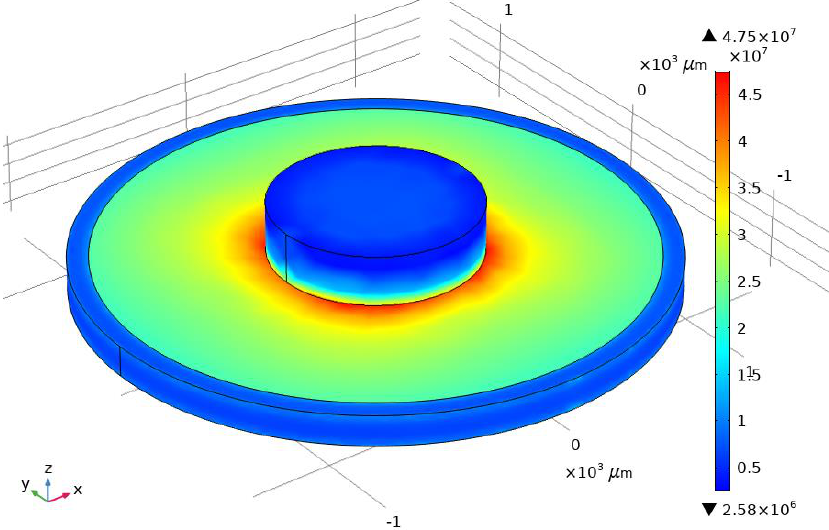
Figure 16. Load distribution in the presence of IM.